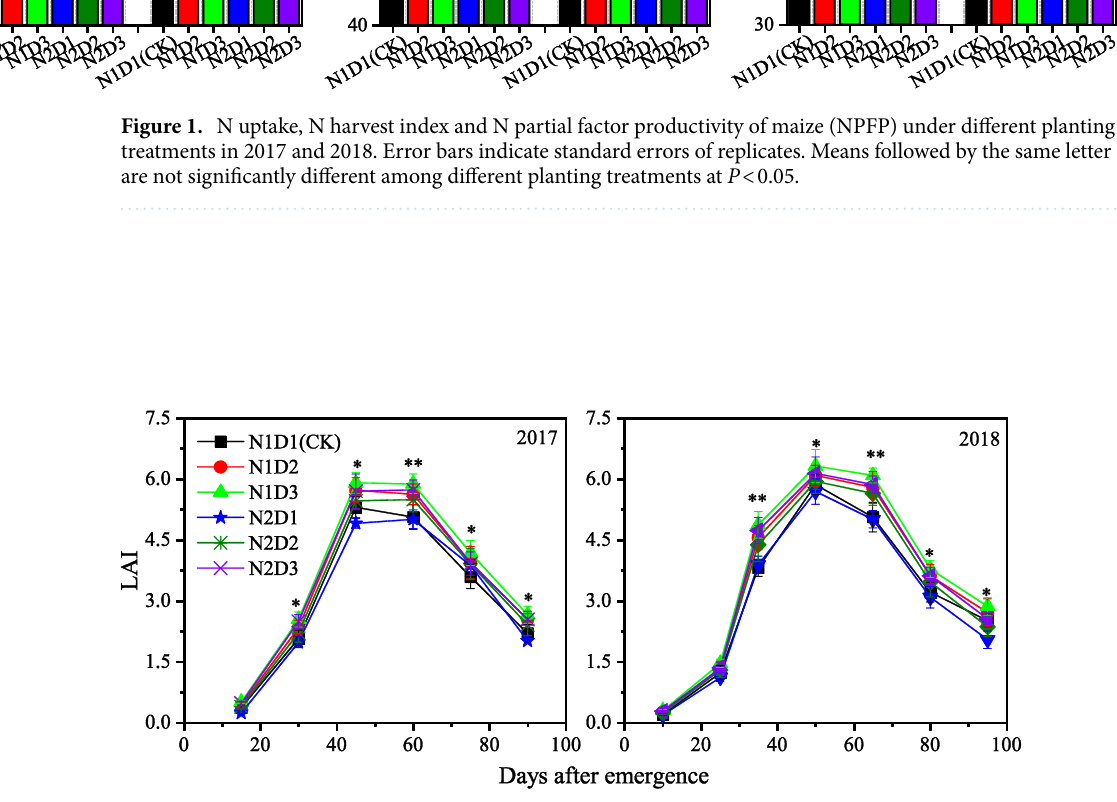
Figure 2. Maize leaf area index (LAI) trends during growing season as affected by planting treatments. Each data point is the mean ± S.E. of three replications with * and ** are significant at P < 0.05 and P < 0.01,